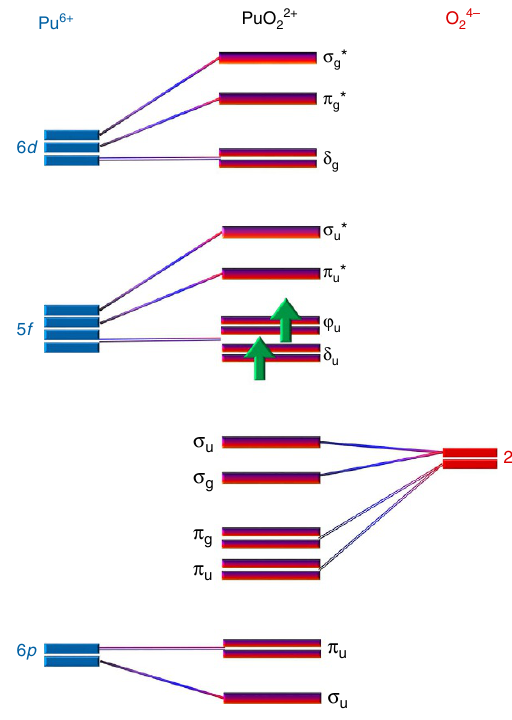
Figure 1 | Molecular orbital scheme. A qualitative molecular orbital scheme of PuO 2 2 þ adapted from (refs 23,24). Only frontier electrons are